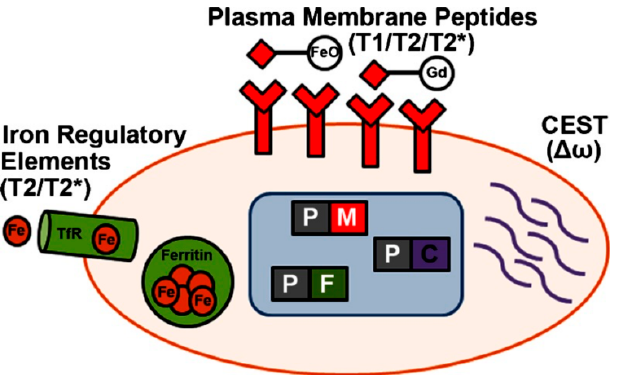
Figure 4. Schematic representation of MRI gene reporter integration for in vivo detection of cell fate decisions. CEST (chemical exchange of saturated magnetization), TfR (transferrin receptor).